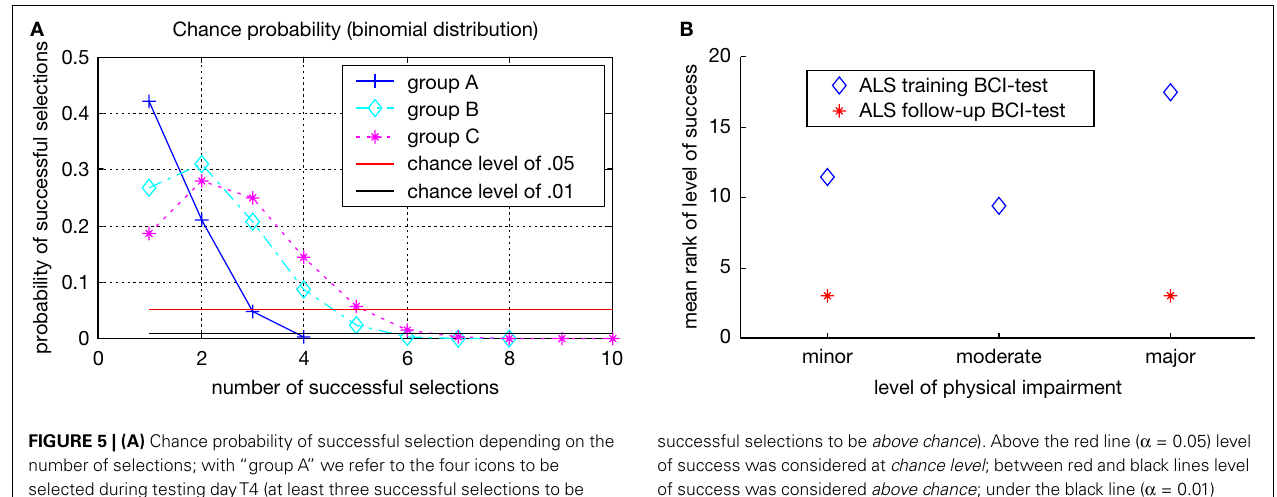
( Table 3 ); neurophysiological ( Tables 4 and 6 ); training BCI-test communication skill ( Table 7 ); follow-up BCI-test communi- cation skill ( Table 8 ); quality of the BCI-based communication